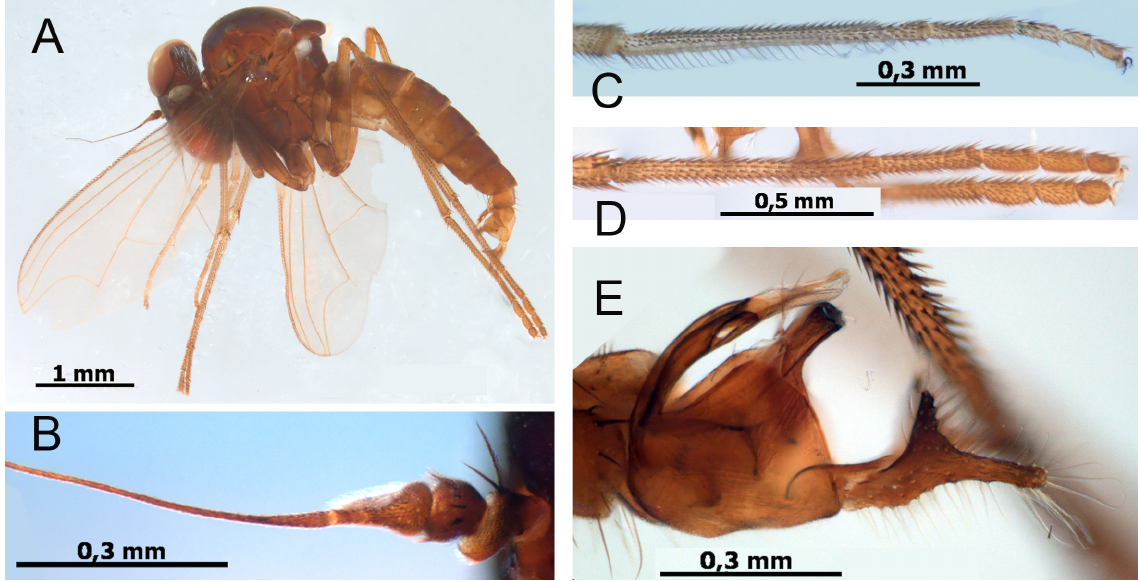
Fig. 1. Amblypsilopus spiniscapus sp. nov., holotype, ♂ (ZMUK). A . Habitus. B . Antenna. C . Fore tarsus. D . Hind tarsus. E . Hypopygium after maceration, right lateral